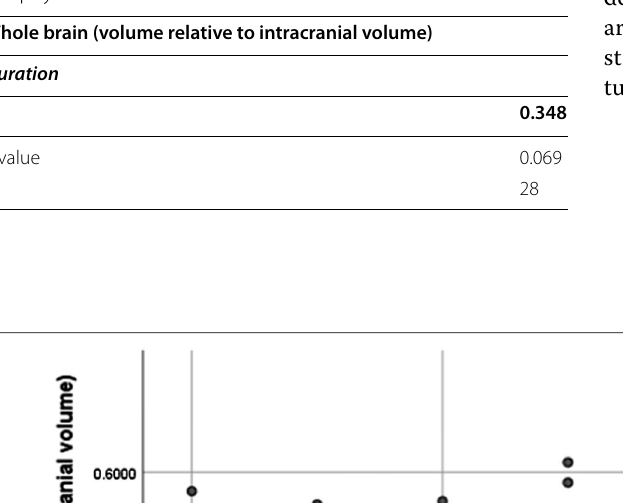
Table 13 Relation between duration of illness and degree of volume loss of the whole brain in patients with whole